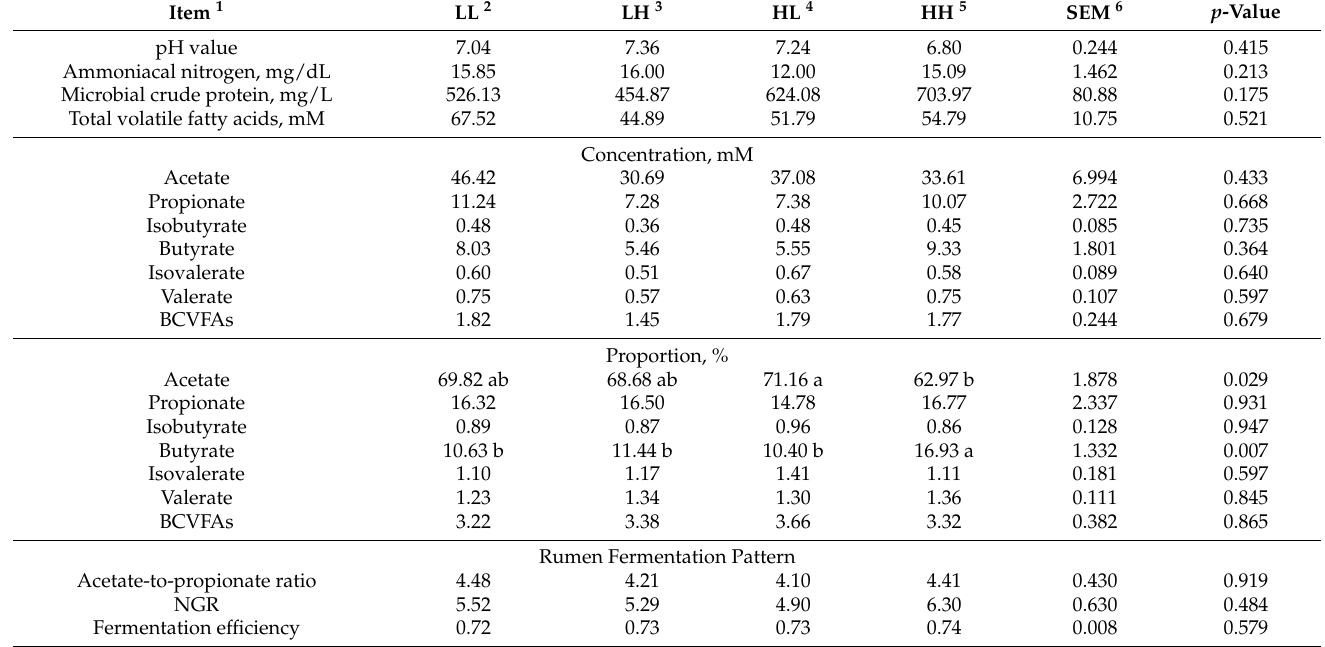
Table 2. Effect of the energy provision strategy on the rumen fermentation characteristics of Hu sheep.